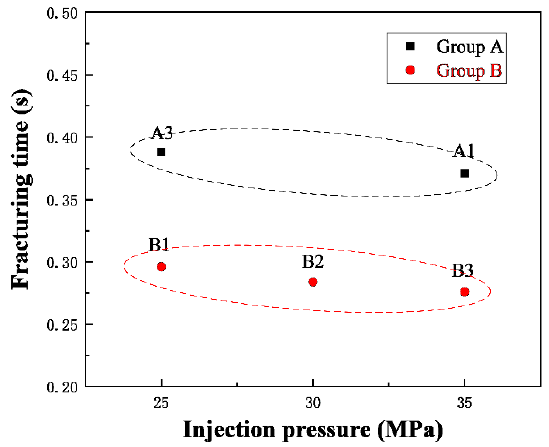
A1) and ( b ) soft rock (specimen B2). and ( b ) soft rock (specimen B2).